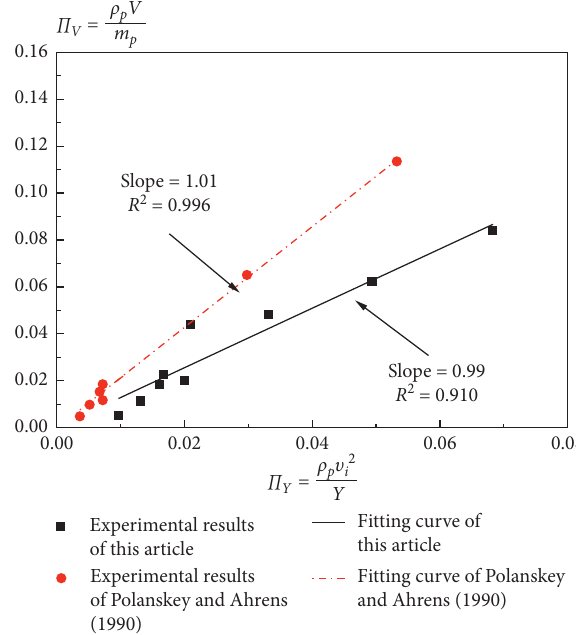
V and Π Y based